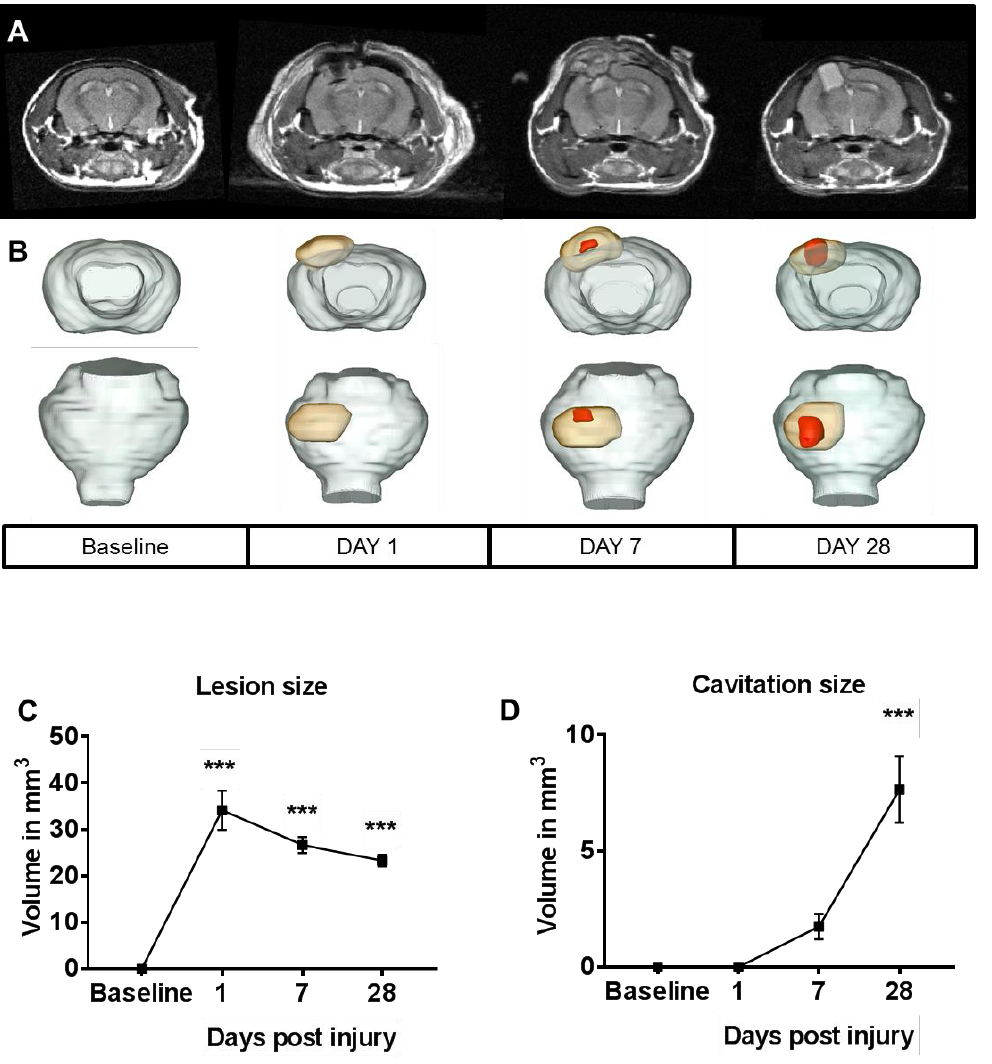
Figure 1. T 2 -weighted magnetic resonance imaging (MRI) monitors longitudinal changes in lesion size and cavitation after contusion injury in aged animals. ( A ) Axial T 2 -weighted magnetic resonance (MR) representative images of an injured animal, acquired a day prior to injury (baseline), and on days 1, 7, and 28 post injury on a 14.1-tesla MRI system using the following parameters: echo time (TE)/repetition time (TR) = 12/2000 ms; slice thickness = 0.5 mm; number of averages = 8; matrix = 256 × 256; field of view (FOV) = 30 × 30 mm 2 ; acquisition time = 8 min. ( B ) Corresponding three-dimensional (3D) rendering of the lesion (orange) and cavitation (red) over time for the same injured animal. ( C ) Lesion size (expressed in mm 3 , defined as a mix of hyper- and hypo-intense contrasts) was measured starting at one day post injury. One-way ANOVA revealed significant differences (F = 47.77; p < 0.0001). Tukey post hoc test revealed differences between groups; n = 5–6/time point. ( D ) Cavitation (expressed in mm 3 , defined as hyperintense contrasts) was measured starting at seven days, and peaked at 28 days post injury. One-way ANOVA was used for non-parametric analysis (Kruskal–Wallis test), and Dunn’s multiple comparison test was used post hoc. Error bars represent group means and standard errors of the mean (SEM); *** p < 0.01.